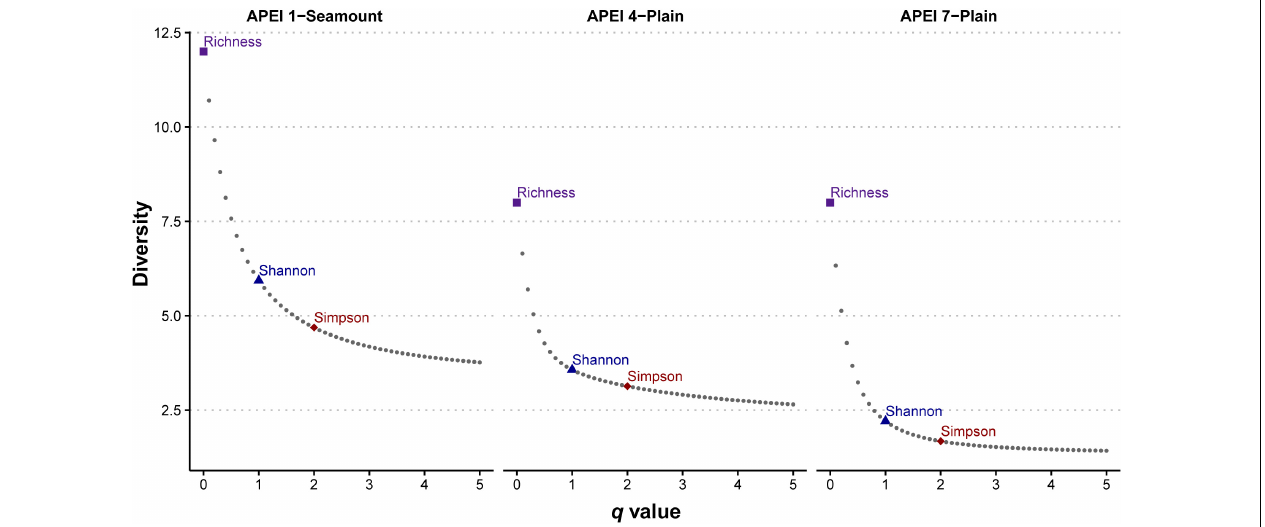
FIGURE 3 | Diversity profile plots for scavenging amphipods in western APEIs (Area of Particular Environmental Interest) 1, 4, and 7 showing higher diversity in APEI 1 and a strong dominance of species in each community. X-axis indicates different values of q (i.e., diversity order), with y-axis indicating diversity as effective number of species (i.e., Hill numbers). Values of q = 0, q = 1, and q = 2 are indicated as this correspond to values of species richness, the inverse of Shannon-Wiener entropy index, and the inverse of Simpson’s concentration index,